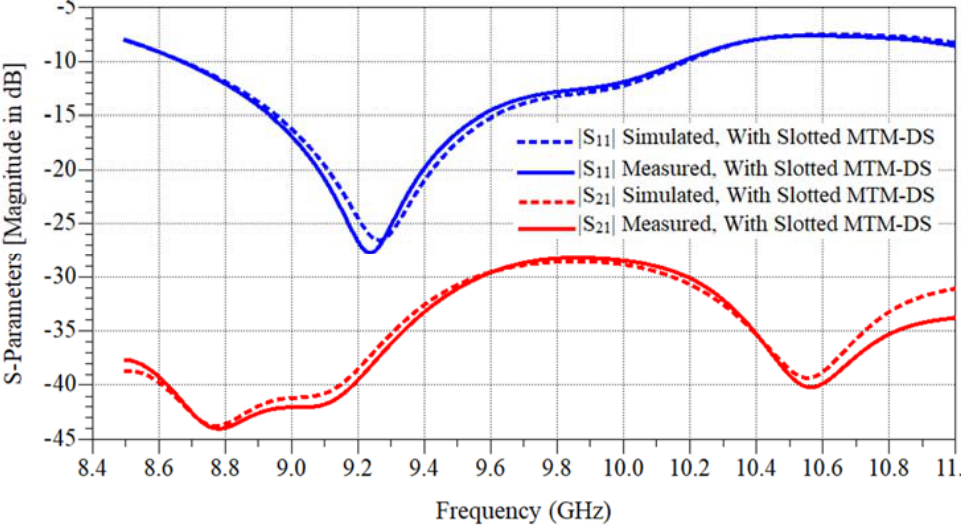
Figure 11. Simulated and measured S-parameters results of the fabricated 2 × 1 antenna microstrip patch antenna array with slotted MTM-DS. Table 2. Measurements resulted from the three isolating